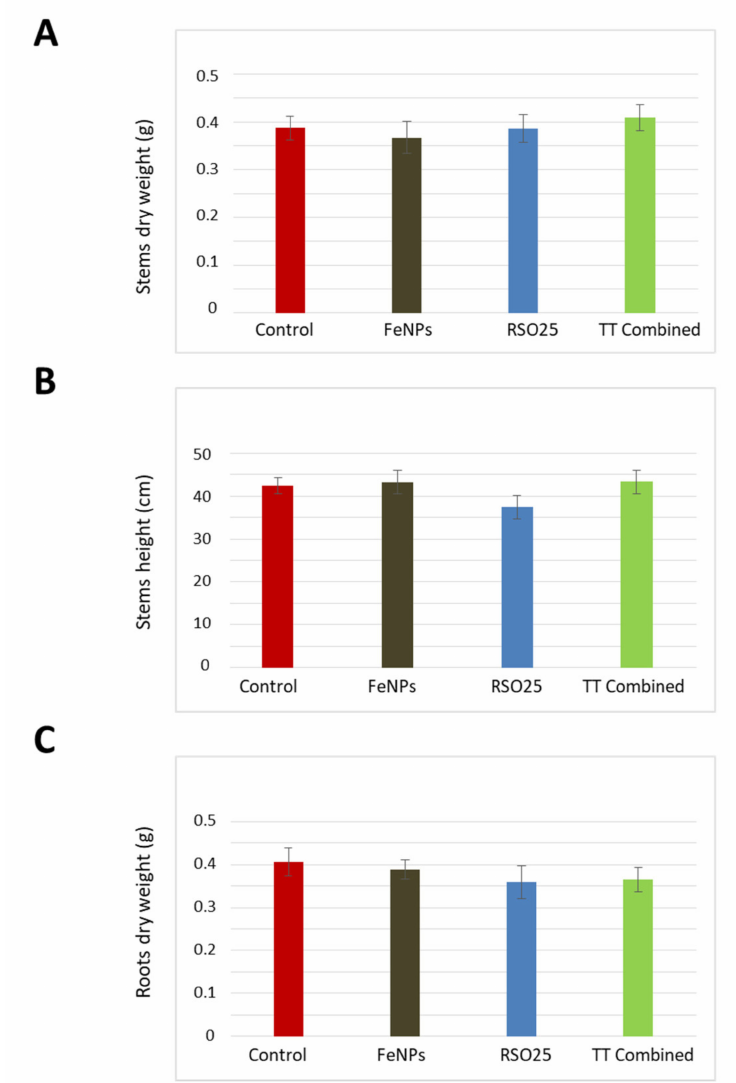
Figure 4. Dry mass of stem ( A ), roots ( B ), and height of the stems ( C ) of Triticum aestivum plants treated with metallic Fe-containing polymeric nanoparticles (FeNPs), inoculated with Bacillus aryabhattai (RSO25) and exposed to the combination of both treatments (TT Combined) for 45 days. Values represent means ± SD, n =